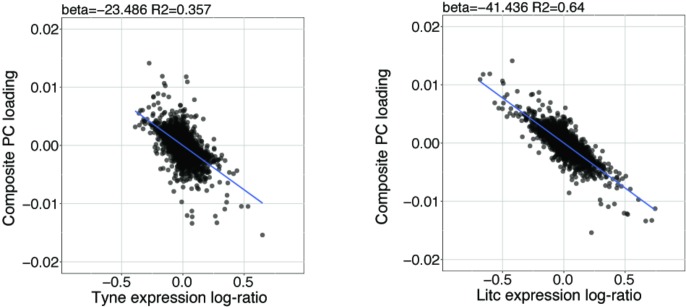
Parallel marine-freshwater divergence in gene expression quantified using the Composite PC loadings (y-axis, see also Figure 1c) is highly correlated with river-specific marine-freshwater divergence in gene expression River Tyne, Scotland (left) and Little Campbell River, Canada (right) quantified as the log of marine/freshwater expression values.Each point represents a transcript. Negative values on x- and y-axes represent stronger expression in freshwater fish and positive values represent stronger expression in marine fish.